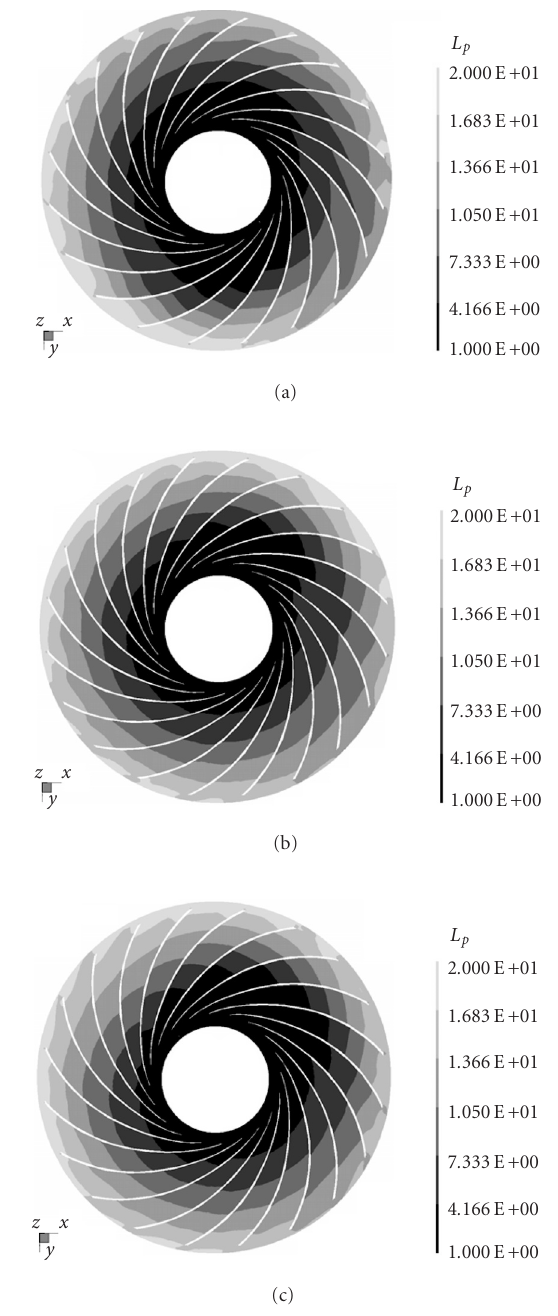
Figure 13: Static pressure distribution on impeller center plane in the vaneless case at near-surge conditions: (a) starting position, (b) 1 / 3 revolution, and (c) 2 / 3